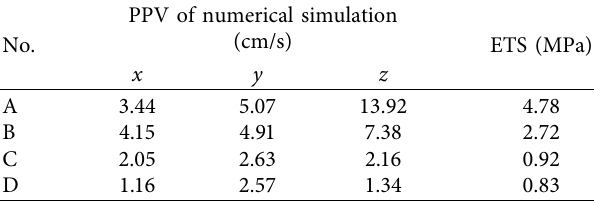
Table 9: The distribution of PPVs and ETS.